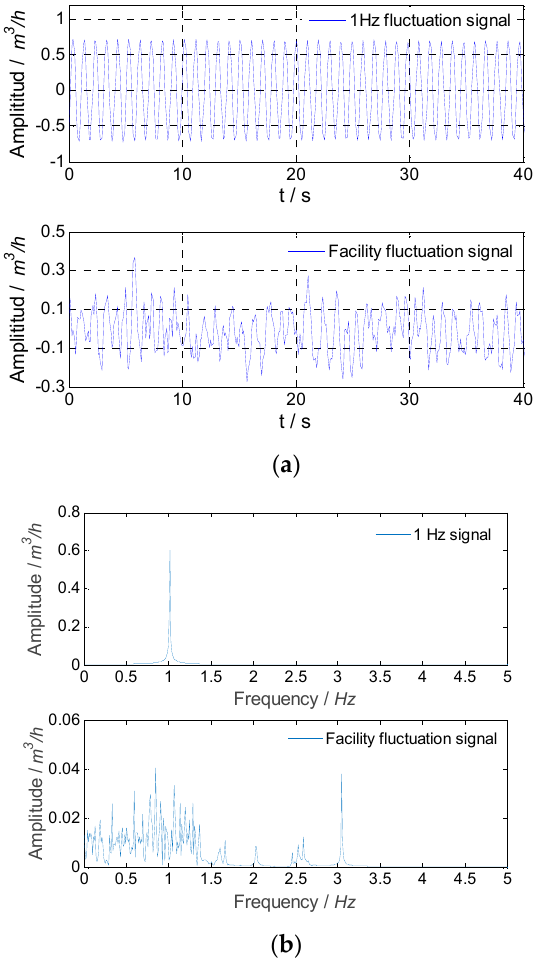
Figure 15. Experimental result for extracted signals in experiment No. 2: ( a ) the flow fluctuation signal; ( b ) frequency spectrums.